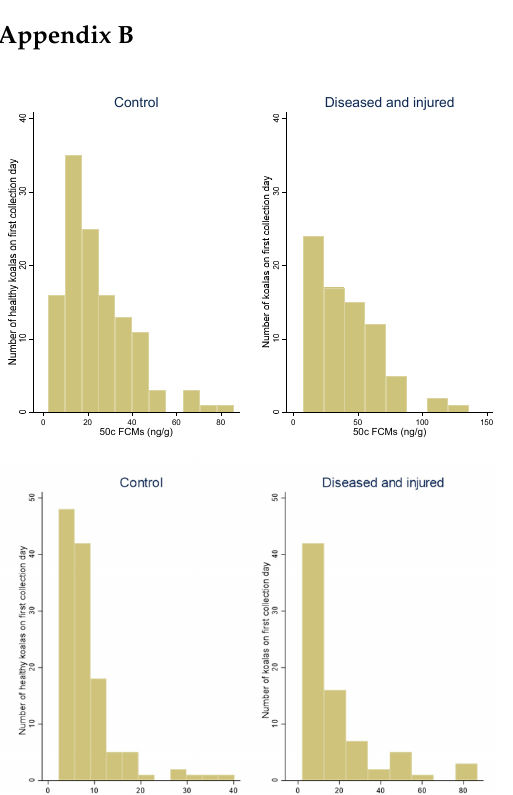
Figure A1. The FCM (faecal cortisol metabolites) values of the control only and of diseased and injured koalas, measured with 50c EIA and cortisol EIA (enzyme immunoassays). FCM values were not normally distributed (Shapiro–Wilk Test; p -values < 0.001).